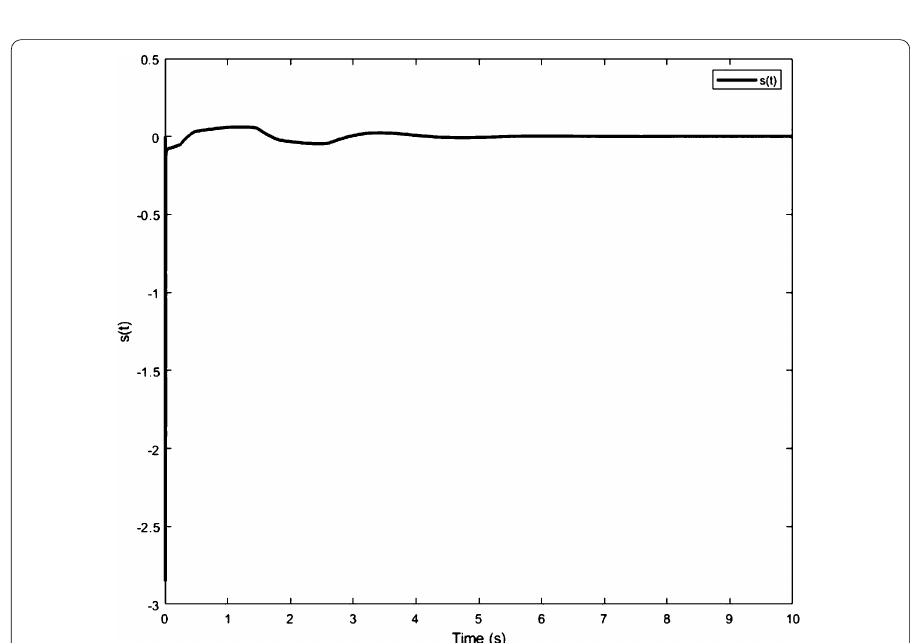
Figure 3 Time history of the sliding manifold applied for the Arneodo